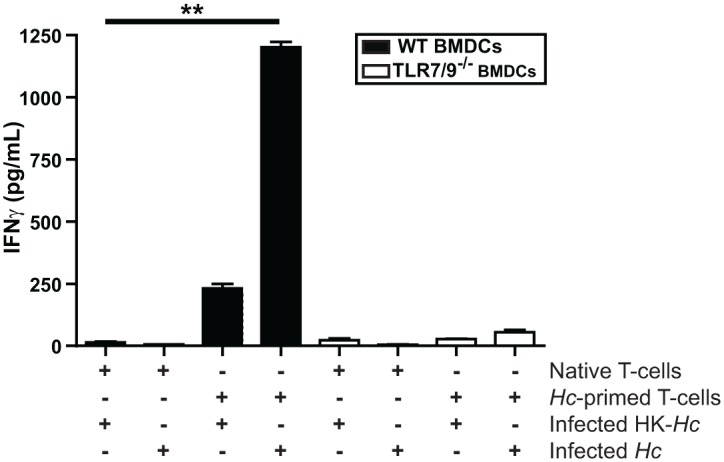
TLR7/9 is essential for proper IFNγ production during DC-T cell interactions.Wild-type and TLR7/9-/- BMDCs were cocultured with heat-killed or live Histoplasma capsulatum (HK-Hc or Hc, respectively) at an MOI of 2. One hour post infection spleen-purified native or Histoplasma-primed CD4+ T cells were added to the BMDCs. Supernatants were collected at 48 hpi and IFNγ was quantified by ELISA. All error bars indicate SD. **p < 0.001; p values were determined by ANOVA.